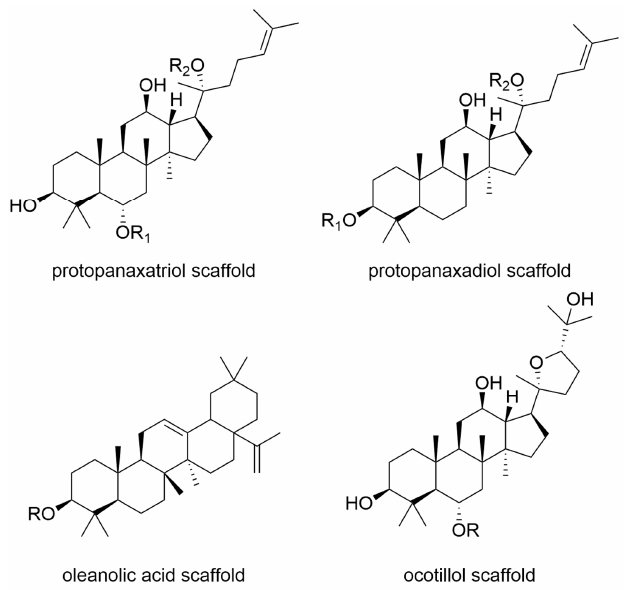
Figure 4. The main aglycone scaffolds from ginsenosides found in Panax quinquefolius and Panax ginseng . Panax ginseng